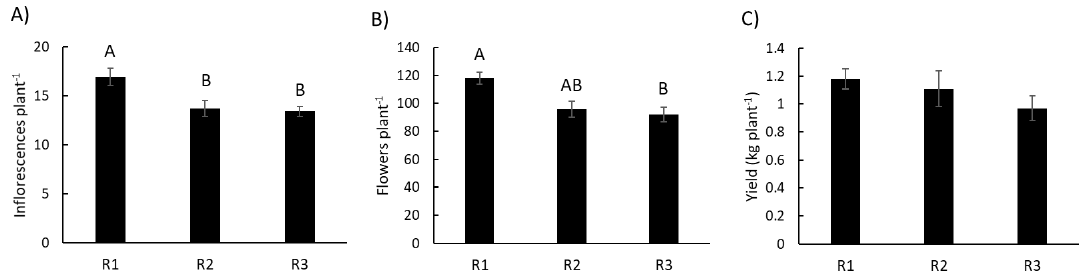
Fig. 4. Number of inflorescences (A) and flowers (B), and fruit yield (C) in strawberry cv. Polka in different runner removal treatments in June 2019. R1 = runners removed three times; 25 July, 15 August, and 4 September 2018, R2 = runners removed on 10 September 2018, R3 = no runner removal. Vertical bars represent ± SEM, n = 4. Values marked with the same letter are not significantly different at p < 0.05 by Tukey’s test.